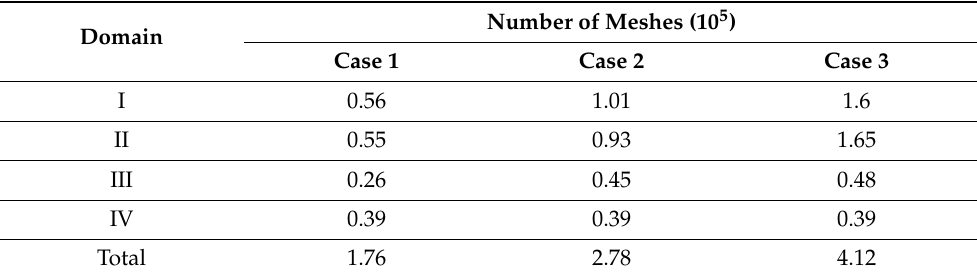
Table 4. Mesh information in the three cases.